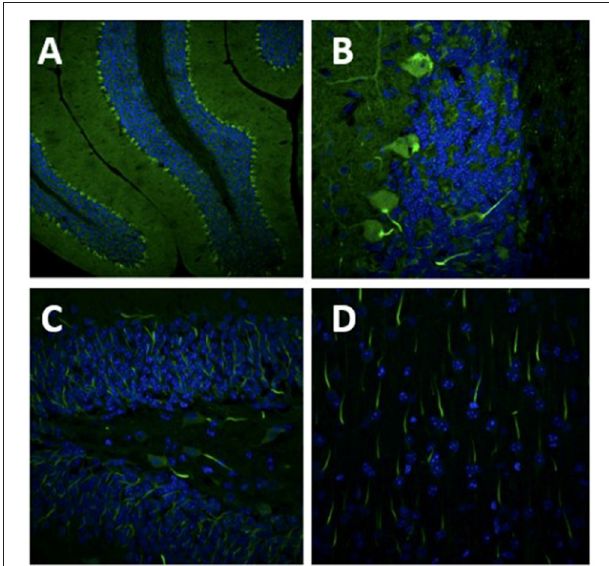
FIGURE 3 | Images of (A) 10x magnification and (B) 60x magnification of cerebellar tissue demonstrating antigen staining of the patient’s Trim46 antibody (in green) and nuclei are in blue. (C) There are axon initial segments staining in green in the dentate gyrus and (D) in the cortex as well. Images courtesy of Dr. Christopher Bartley and team at University of San Francisco (USCF) Weill Institute for Neurosciences laboratory